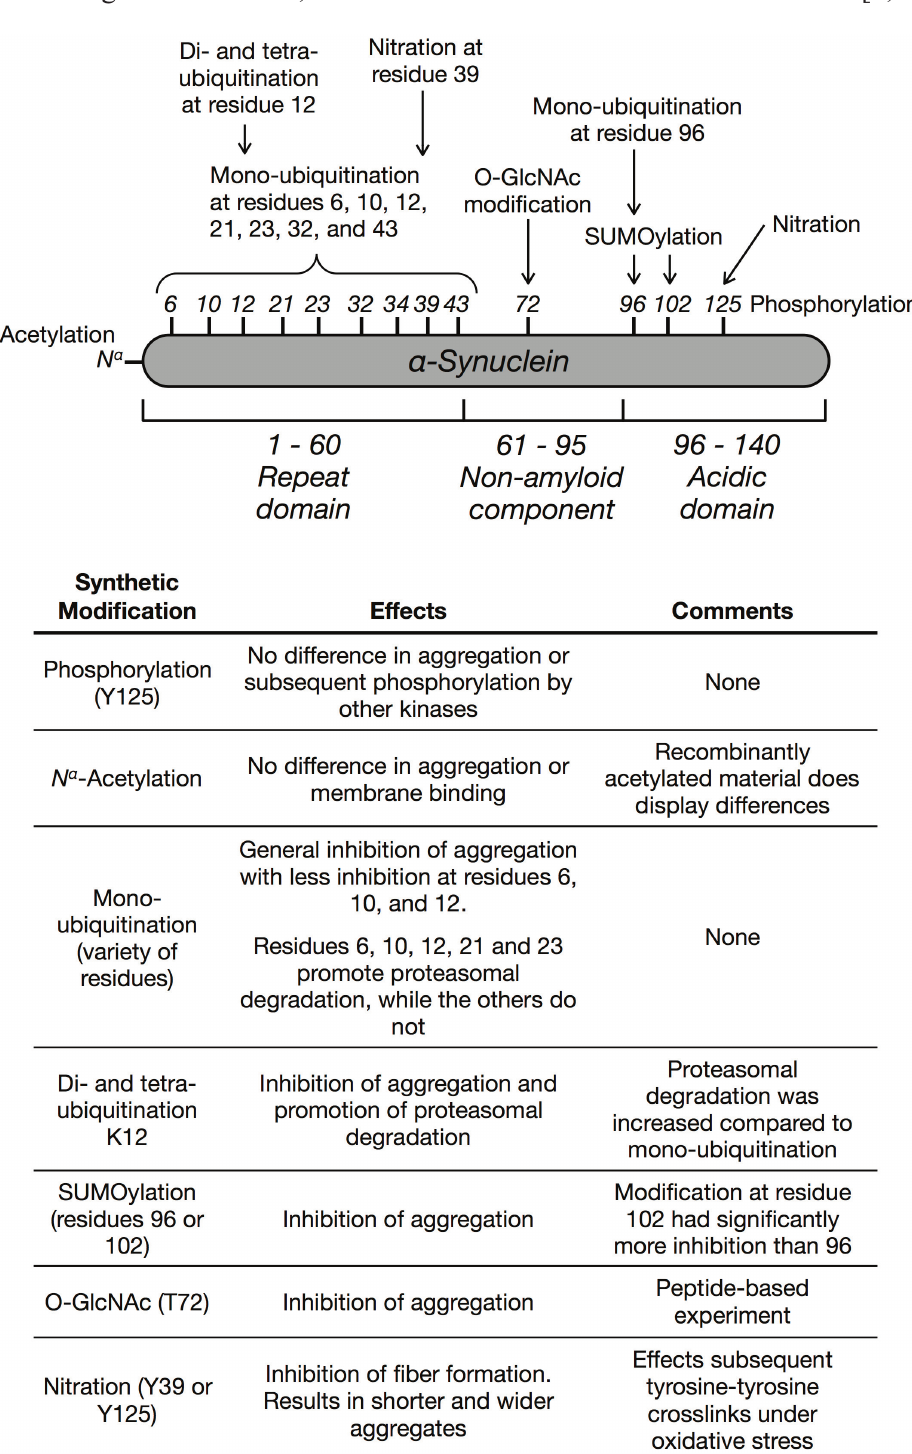
Figure 1. Schematic representation of the protein (cid:2)-synuclein, consisting of an N-terminal repeat domain, the non-amyloid beta component domain that is required for aggregation, and a C-terminal acidic domain. The sites and identities of posttranslational modifications that have been studied using synthetic proteins or peptides are highlighted and the general effects are